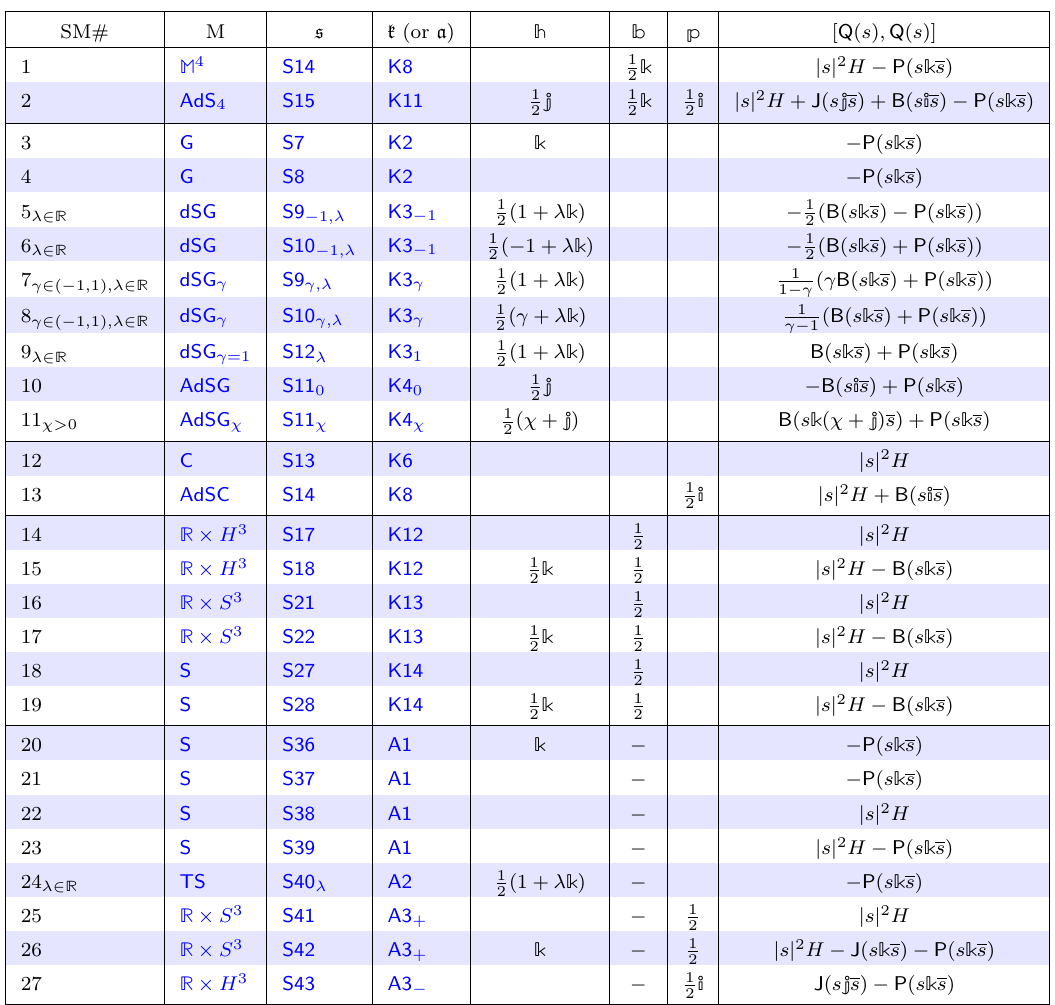
Table 14 . Simply-connected spatially-isotropic homogeneous superspaces.